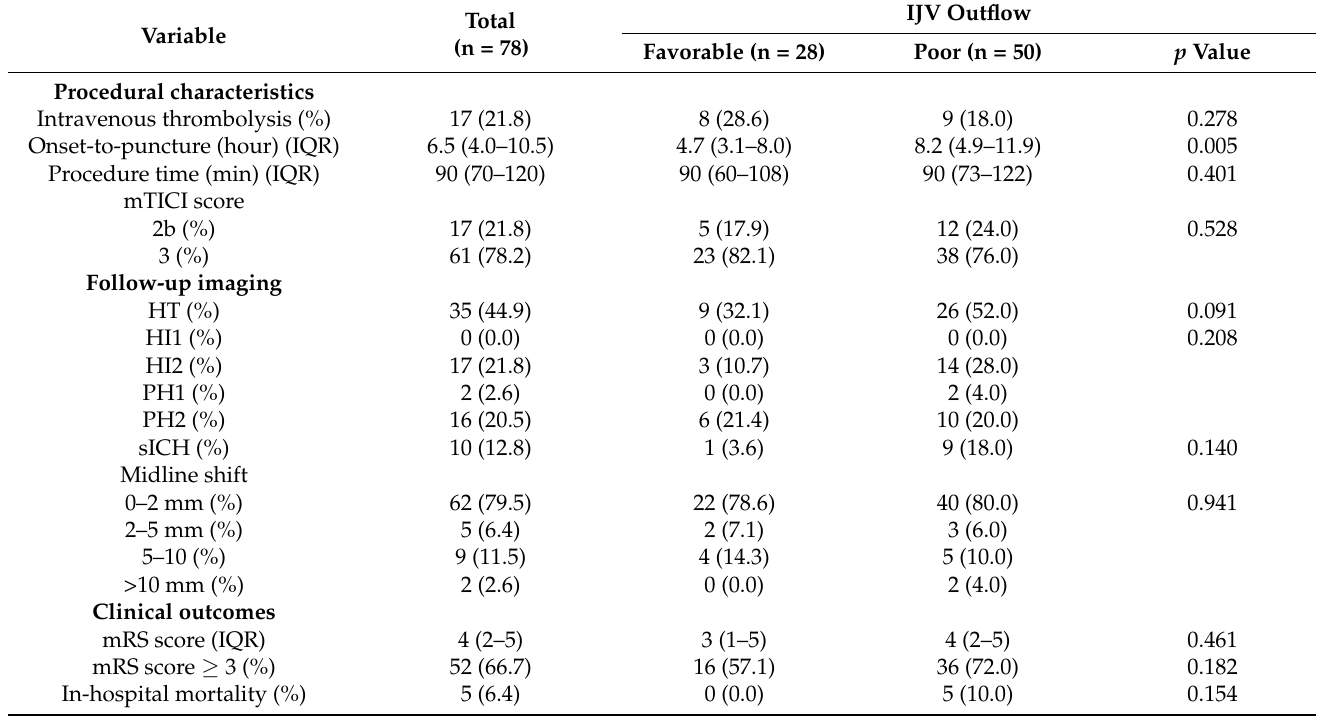
Table 2. Procedural characteristics, follow-up imaging, and clinical outcomes of the study cohort classified by the outflow of transverse sinus and internal jugular vein on the affected side.